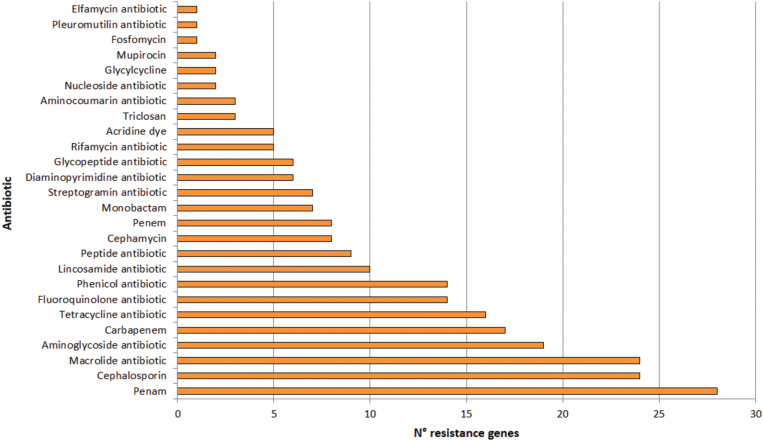
Number of genes conferring resistance to different types of antibiotics in the Puquio de Campo Naranja plasmidome. Putative antibiotic resistance genes were identified by the RGI software using the CARD database.